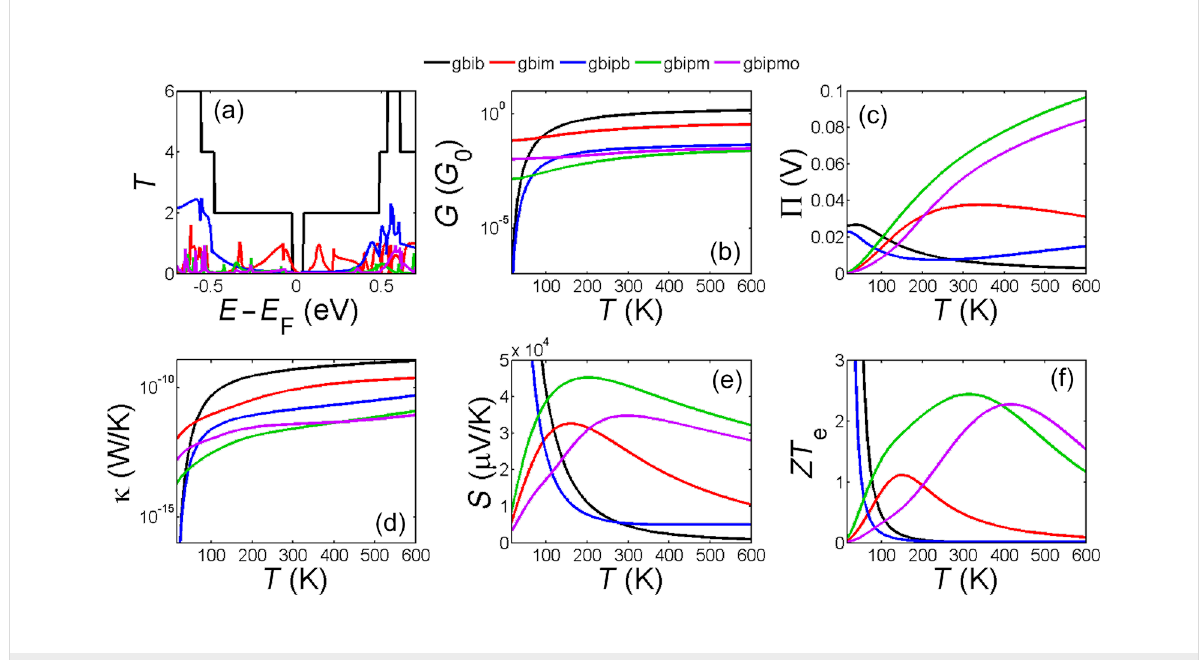
Figure 3: (a) Transmission coefficient T ( E ); (b) electrical conductance ( G ), (c) Peltier ( П ) coefficient, (d) thermal conductance ( κ ), (e) Seebeck ( S ) coefficient and (f) figure of merit as a function of temperature in zigzag bilayer graphene nanoribbon (gbib), bilayer graphene with monolayer lead (gbim), engineered bilayer graphene nanopore (gbipb), engineered bilayer graphene nanopore with monolayer lead and hydrogen termination in pore side (gbipm), engineered bilayer graphene nanopore with monolayer lead and oxygen termination in pore side